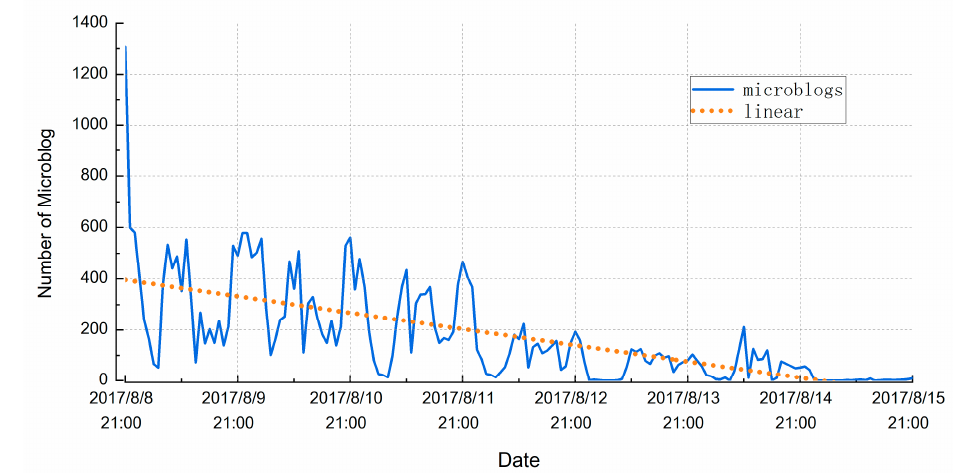
Figure 2. Number of Jiuzhaigou earthquake microblogs over time (after deweighting).